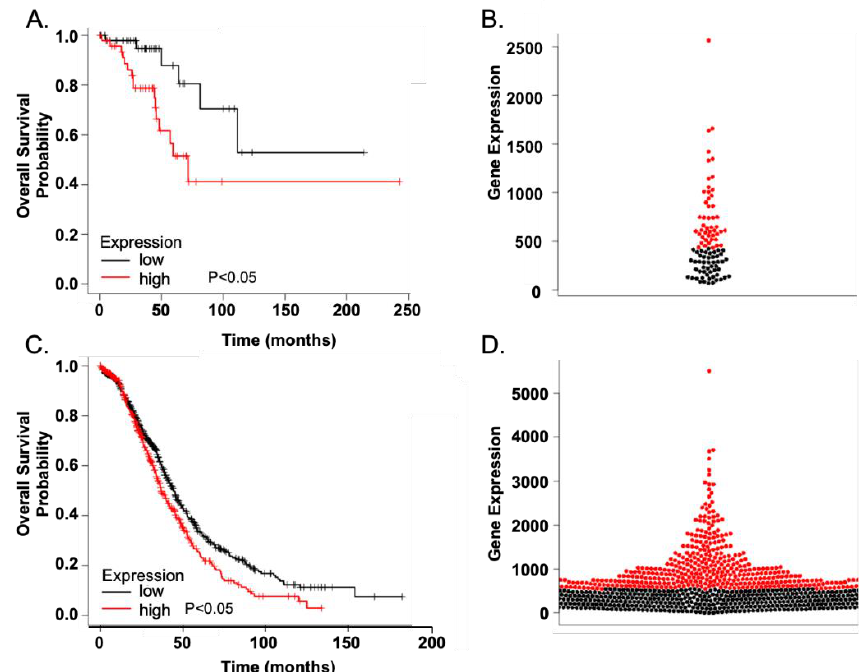
Figure 2. PTP4A3 overexpression in human OvCa is associated with poor survival, even in early stage disease. ( A ) High PTP4A3 expression was associated with poor survival in tumors from 98 patients with stage I/II serous OvCa. Red symbols and line represents the 48 tumor samples with high PTP4A3 expression and black symbols and line represent the 50 tumor samples with low PTP4A3 expression. Patients with low PTP4A3 gene expression showed almost double the length of overall survival: 81.2 vs. 44.3 months. p < 0.05. ( B ) Beeswarm plot showing high expression of PTP4A3 even in early stage OvCa patients. Red and black symbols are from Panel A. ( C ) High PTP4A3 expression is also associated with reduced survival in stage III/IV serous OvCa patents. Red symbols and line represents the 394 tumor samples with high PTP4A3 expression and black symbols and line represent the 629 tumor samples with low PTP4A3 expression. Patients with low PTP4A3 expression had an overall survival of 44.5 months compared to 36.8 months for patients with high PTP4A3 expressing tumors. p < 0.05. ( D ) Beeswarm plot showing high expression of PTP4A3 maintained in a significant population of patients in later stage disease. Red and black symbols are from Panel C.